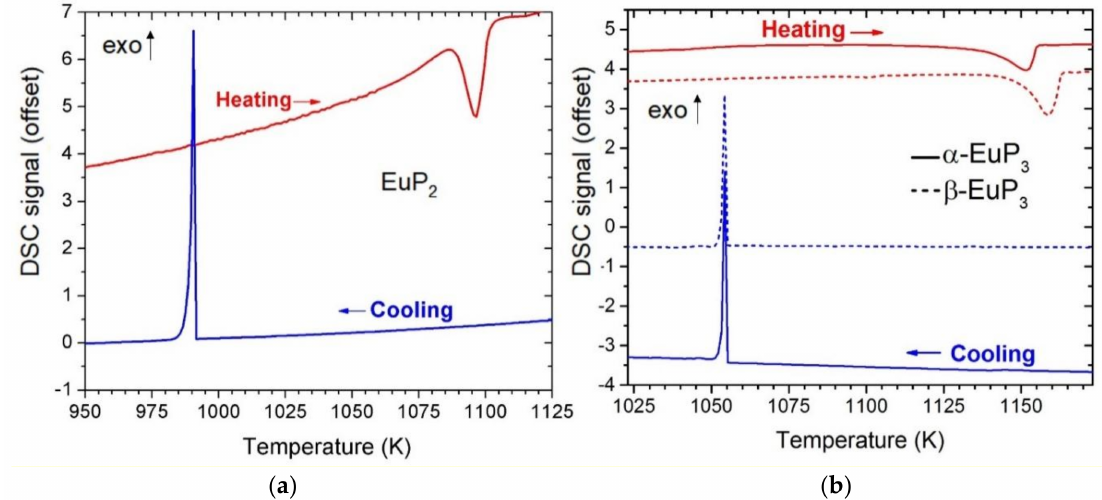
Figure 2. DSC curves for EuP 2 ( a ) and EuP 3 ( b ) phases. Heating is shown in red, and cooling is shown in blue, exothermic direction is shown with exo arrow. For EuP 3 , the solid lines represent the α -phase, and the dashed lines represent the β